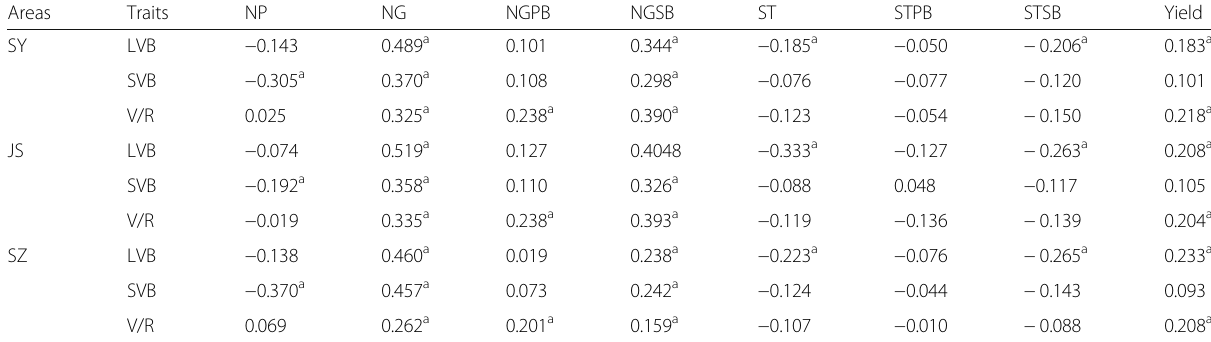
Table 1 The correlation efficiency of vascular bundles to yield components Areas